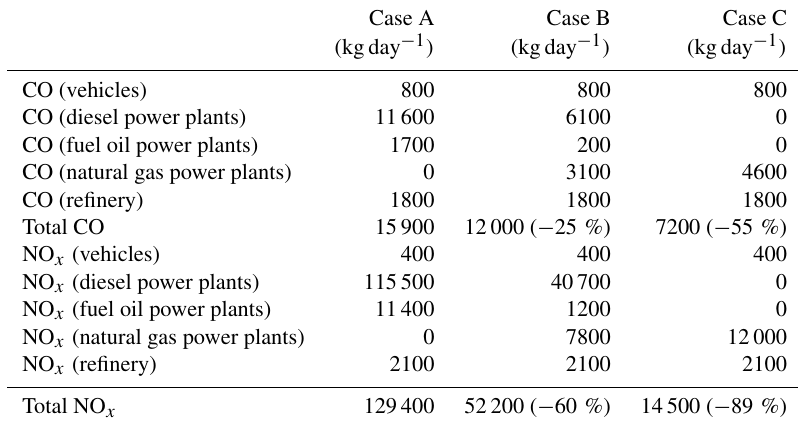
Table 4. Emissions of carbon monoxide (CO) and nitrogen oxides (NO x ) by vehicles, power plants, and refinery. Values are shown for historical emissions (case A), present-day emissions (case B), and planned future emissions (case C). Values are based on pre-processing chemistry emissions as described in the Methodology section. The percent reduction in total emissions relative to case A is shown in parentheses for cases B and